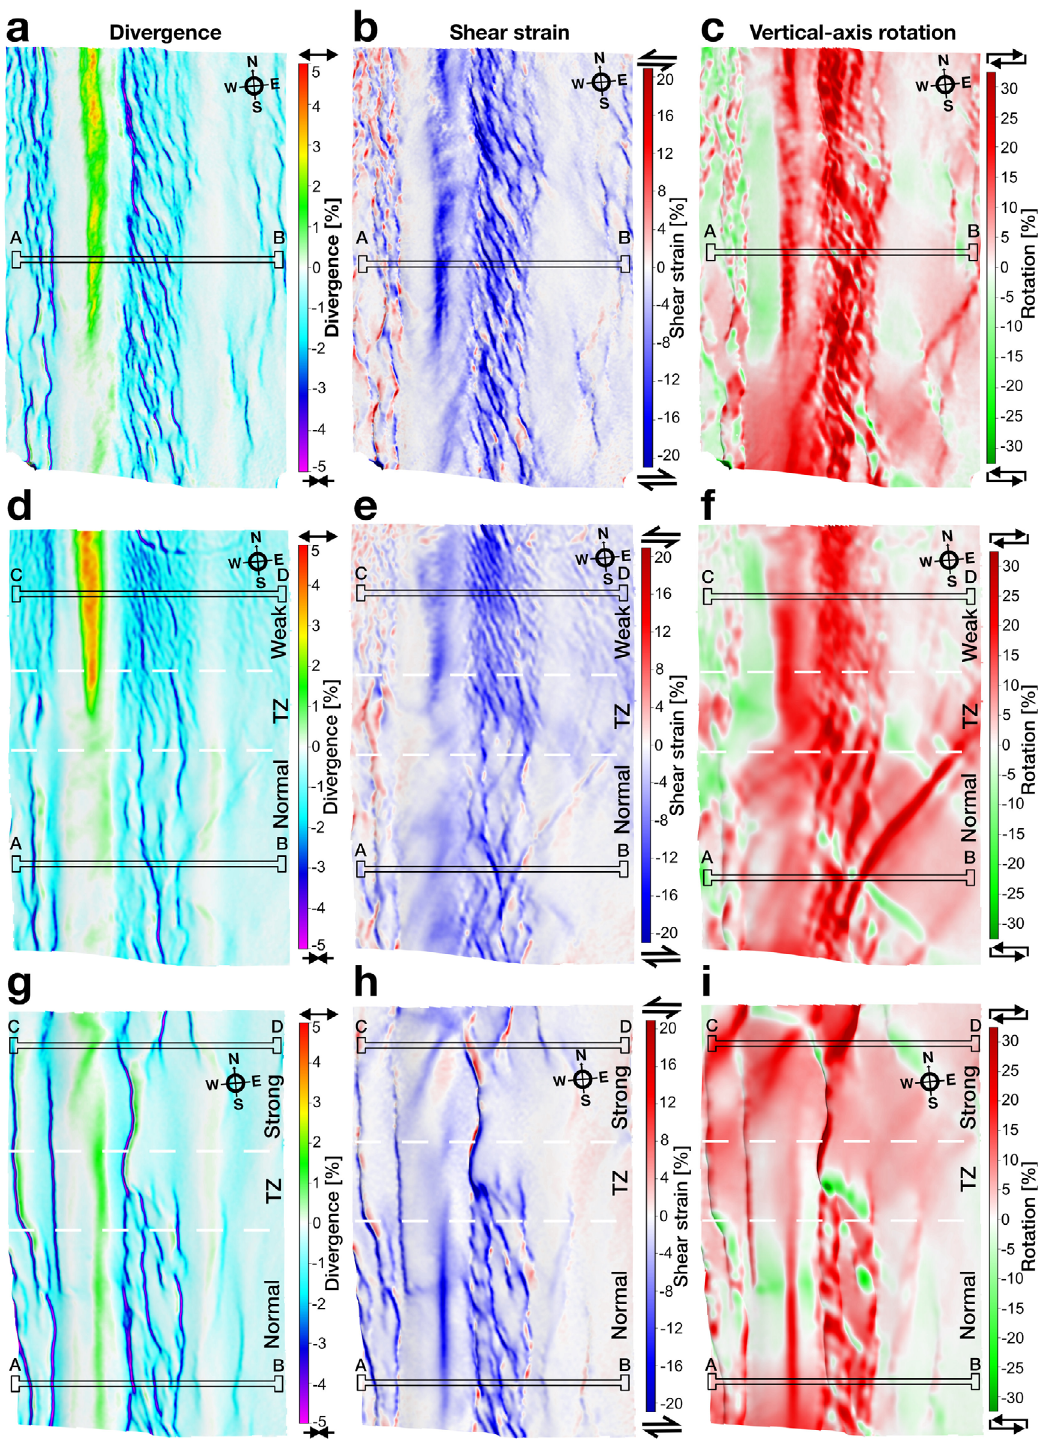
Fig. 5 Images showing cumulative divergence, shear strain, and vertical-axis rotation of model upper-crust in individual experiments. Negative divergence indicates shortening. a Divergence, b shear strain, and c vertical-axis rotation in setup 1 experiments. d Divergence, e shear strain, and f vertical- axis rotation in setup 2 experiments. g Divergence, h shear strain, and i vertical-axis rotation in setup 3 Dextral shear components on thrust and reverse faults as well as the formation of two prominent fault sets in the central zones: clockwise particle rotation in the central zones (Figs. 4a – c, 5) margin-parallel dextral oblique-slip thrust faults and NW-striking point to dextral transpression affecting the entire width of the sinistral oblique-slip reverse faults (Figs. 4a – c, 6). In places, the central zone, i.e., the model volcanic arc. The model fault sets model reverse faults converge downward and form pop-up enclose rhomb-shaped domains of diminished internal deforma- structures (Supplementary Fig. 5), similar to those observed by tion, akin to those recognized in the SVZ 10 – 12 and the central Schreurs and Colletta (1998) 41 in transpression experiments.